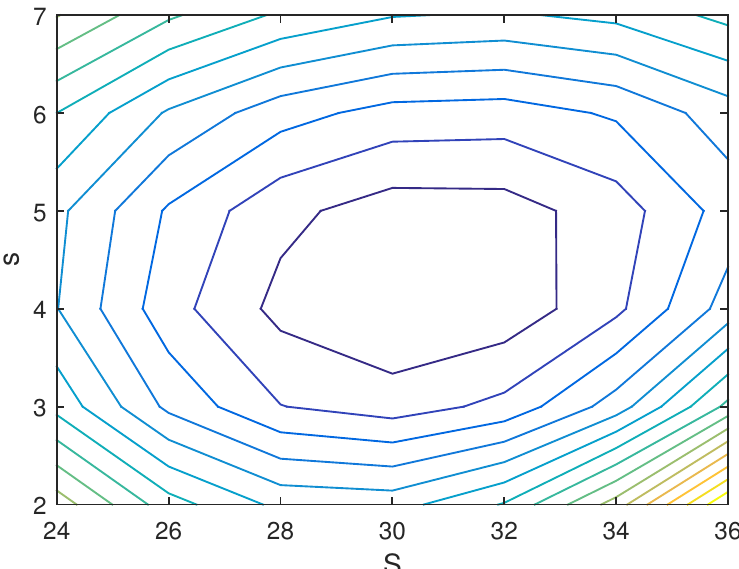
Figure 2. Contour plot of total expected cost rate.